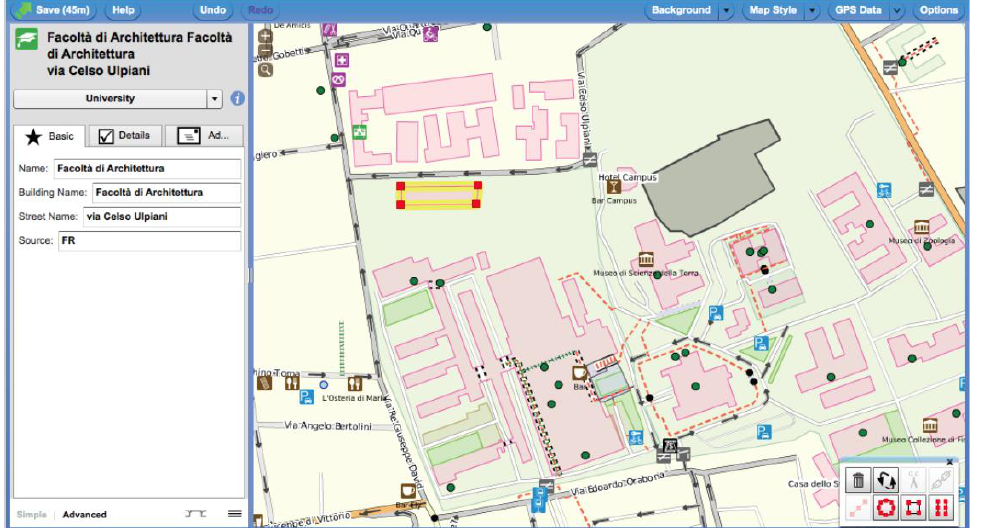
Figure 1. An example of an Open Street Map created by the author for the University Campus in the city of Bari (Italy), highlighting shops and services present in the area and the new building of the Faculty of